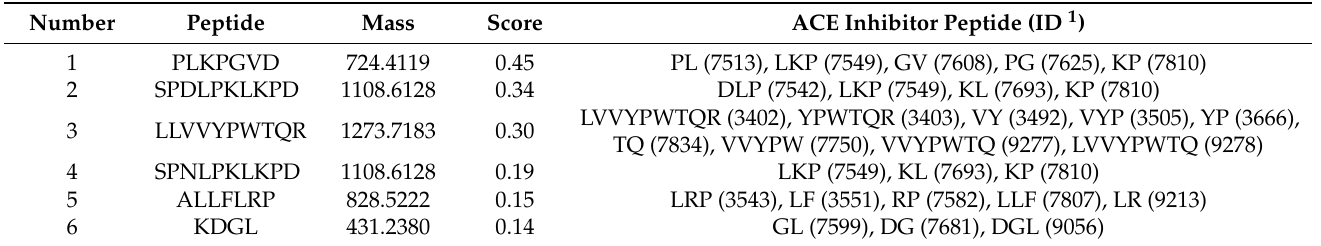
Table 3. Potential ACE active peptides.